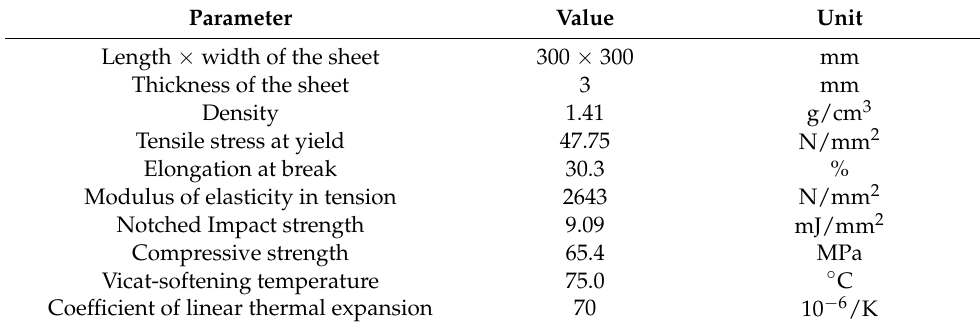
Table 1. Properties of the PVC Trovidur ESA-D material and geometric dimensions of the sheet used in calculation